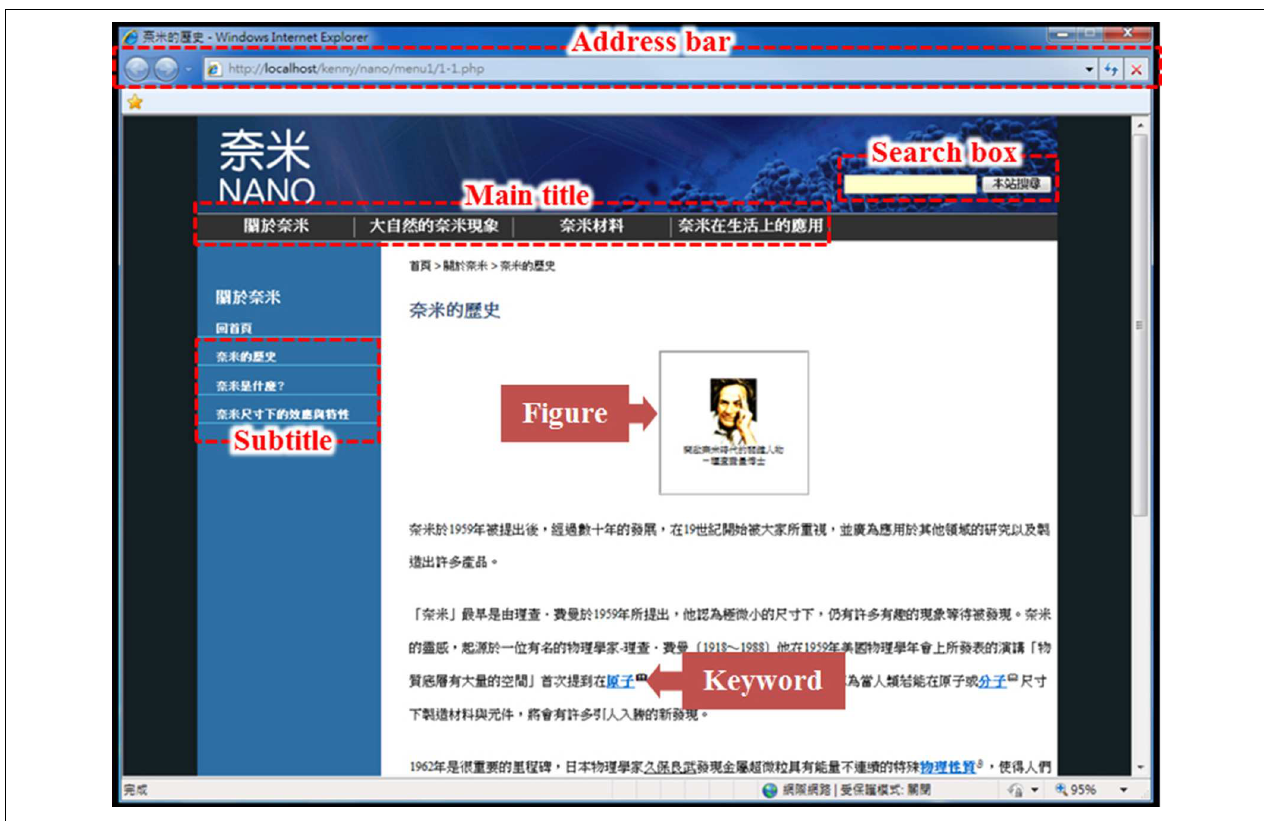
analysis, such as figures, titles, and keywords. This layout of our website also contains a variety of hyperlinks leading to various different